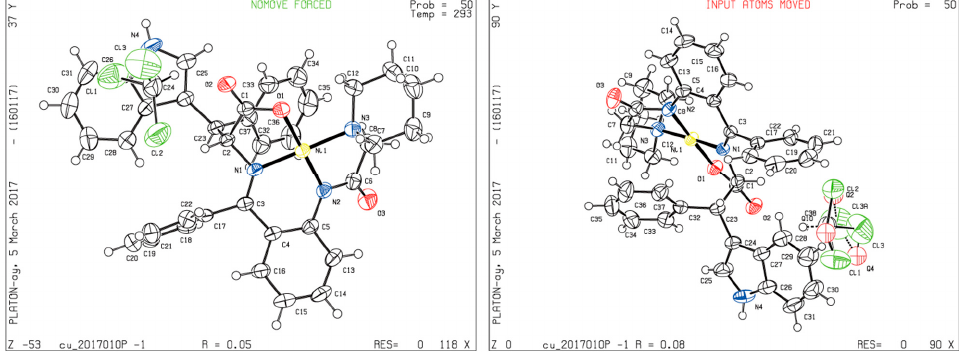
Figure 2. Relative configuration of 4a from different angles.